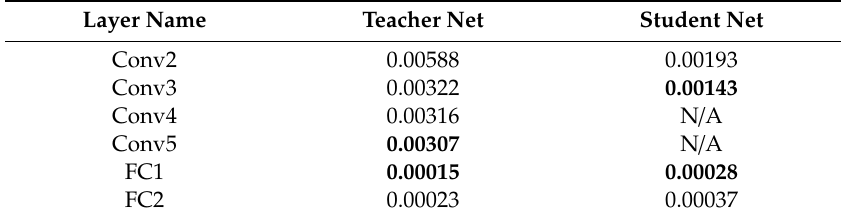
Table 3. LSL loss for teacher network and student network on the People Playing Musical Instruments (PPMI) dataset. The best convolutional layer and the best fully connected layer are marked in bold.